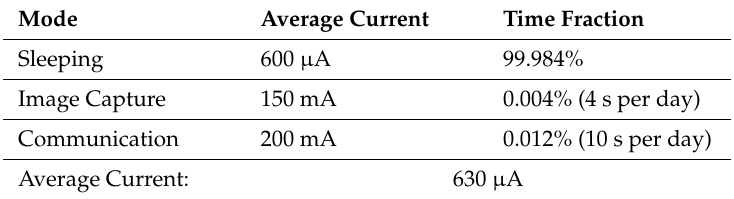
Table 6. Power requirements for RatSpy